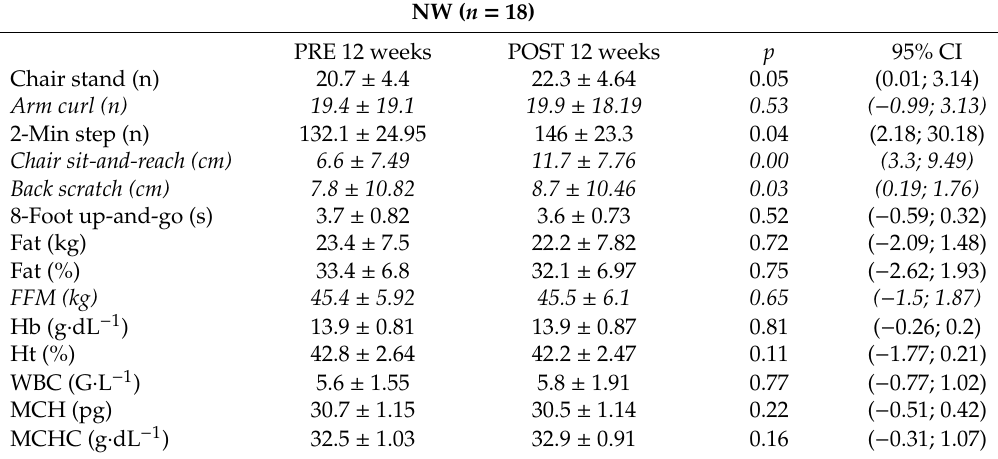
Table 2. Changes in the physical performance, body composition, and blood indicators induced by 12 weeks of NW